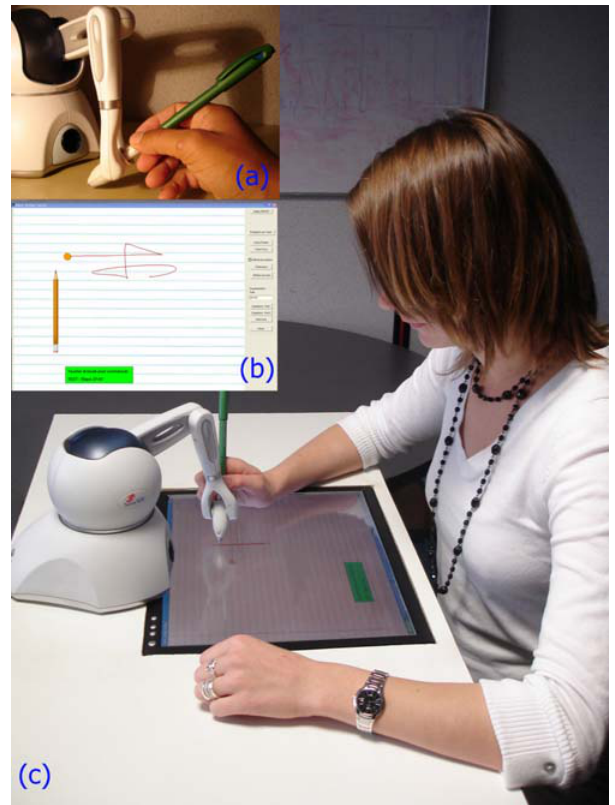
Figure 2. System overview: (a) The modified stylus pen; (b) The graphic User Interface displayed to the subject; (c) A subject undergoing training on the WYSIWYF interface.